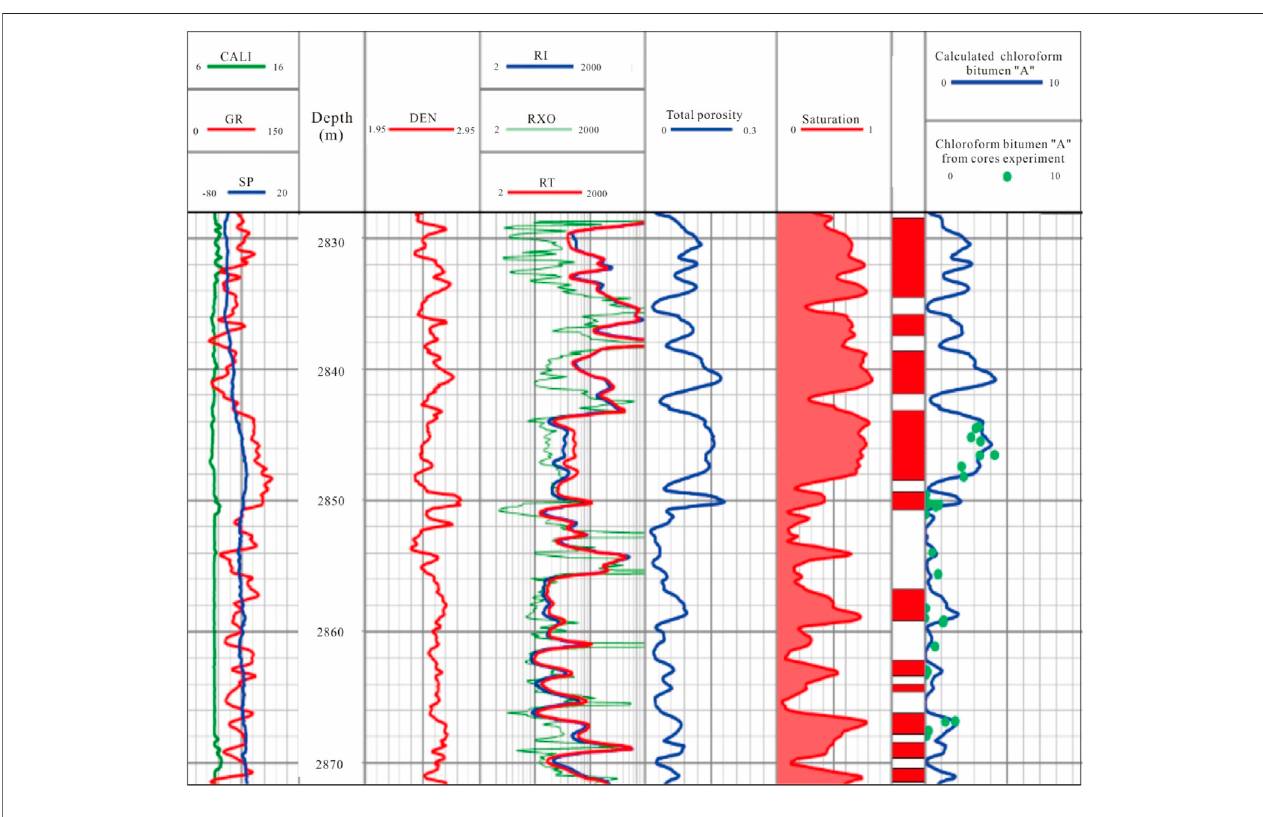
FIGURE 11 | chloroform bitumen “ A" calculated from Well Ji 37.